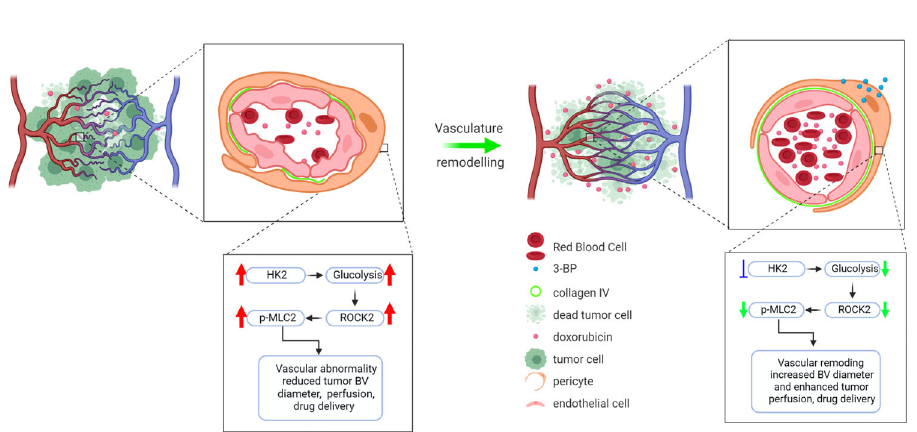
Bar charts, quantitation across the whole tumors, including tumor cores. Results are given as means ± SEM. b Two-way ANOVA. c , d , f – k , p One-way ANOVA. m , n Student ’ s t test. Scale bars in a , o represents 1 cm, e , j , k , l 50 μ m, i , 20 μ m.